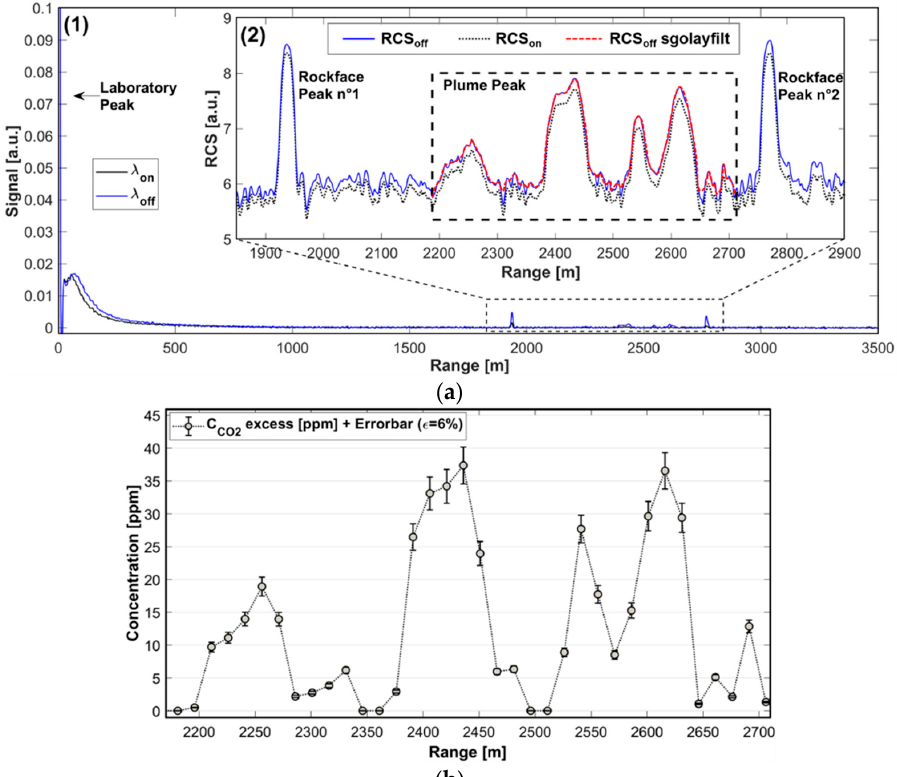
Figure 2. ( a ) Example of a lidar profile acquired during the Stromboli volcano field campaign on 26 June 2015. (1) Data profiles in the form of signal intensity (arbitrary units, a.u.) vs. range (in meters) cleaned by the noise. (2) Detail of the experimental RCS (Range Corrected Signal) and filtering of the OFF channel using a Savitzky–Golay filter algorithm with 13 points in which the plume peak is visible between two rockfaces in the range interval between 1800 and 2900 m. The laboratory peak in (1) provides the start time of the pulse emission and is due to the reflection of some laser radiation inside the mobile laboratory. The two rockface peaks (2), as their name indicates, are due to pulse backscattering by the rockfaces of Stromboli. Finally, the peaks from 2200 to 2700 m are linked to the backscattering of the laser pulse from the plume. ( b ) Particulars of the exceedance of in-plume CO 2 concentration profile (acquired at 11:27, with an elevation 16.98 ◦ and azimuth 237.8 ◦ ). The quadratic sum of statistical (2%) and systematic (5.5%) uncertainties led us to estimate an overall uncertainty of about